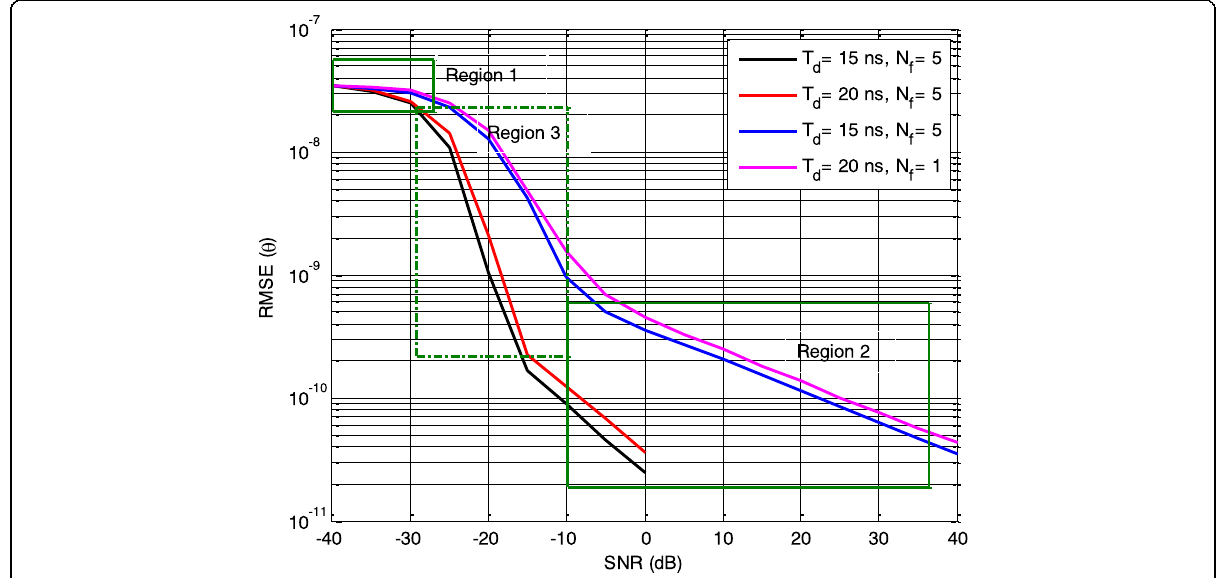
Fig. 4 Lower bound for single and multi-frame estimators vs, SNR (Td = 15 ns, 20